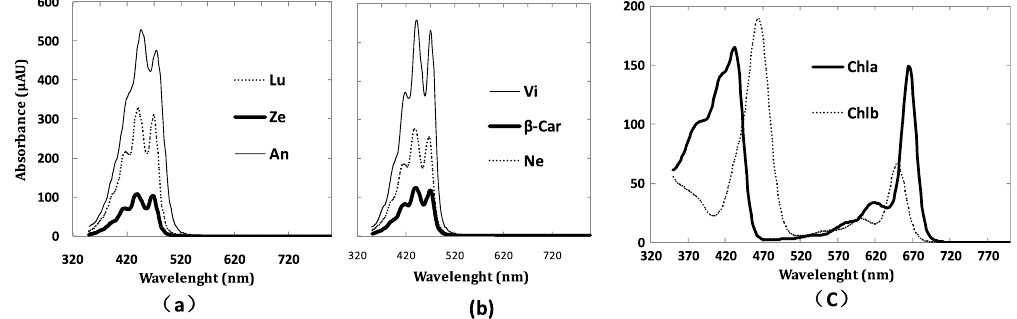
Figure 6. Absorption spectra of pure pigments in acetonitrile/methanol/dichloromethane (60:20:20 v/v/v). The concentrations of Lu (Lutein), An (Antheraxanthin), Ze (Zeaxanthin) in ( a ) and Ne (Neoxanthin), Vi (Violaxanthin), β -Car ( β -carotene) in ( b ) were all 0.2 mg/ml; Chla and Chlb in ( c ) were 0.01